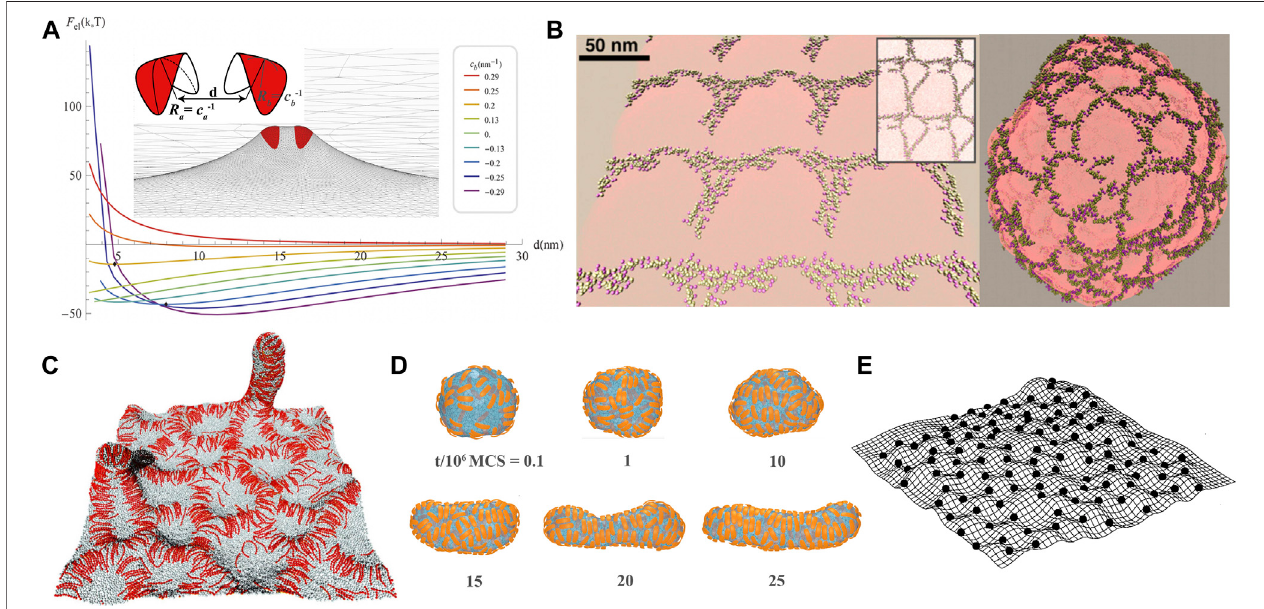
FIGURE5| Membrane-mediatedinteractionsbetweenanisotropicproteininclusions (A) andassemblyofanisotropicproteinsonmembranes (B – E) . (A) Curvature-induced elastic energy F el versus distance d of two BAR-like membrane scaffolds for different values of scaffold curvature c b (Schweitzer and Kozlov, 2015)(CC BY 4.0). The BAR-like scaffoldhasprinciplecurvatures c a and c b asillustratedintheinset.Whenprojectedtoinitialmembraneplane,thescaffoldhasanellipticalshapewithsemi-axesof6.5and1.5 nm. Themembranebendingrigidity κ (cid:1) 20 k B T . (B) LinearaggregationofN-BARson fl atandvesicularmembranesobservedincoarse-grainedMDsimulations(Simunovicetal., 2013).Copyright(2013)NationalAcademyofSciences. (C) Side-by-sidealignmentofBAR-likeparticlesonmembranebulgesandtubes(Noguchi,2016;NoguchiandFournier, 2017), with permission of The Royal Society of Chemistry. (D) MC sequence of con fi gurations of an initially spherical vesicle remodeled by arc-shaped scaffold. Reprinted from BonazziandWeikl(2019),copyright(2019),withpermissionfromElsevier.Freescaffoldsunboundtothemembranearenotshownhereforclarity. (E) Assemblyofsaddle- shaped protein inclusions (modeled by point-like particles that locally impose two opposite eigenvalues of the membrane ’ s curvature tensor) into regular pattern on the membrane. Reprinted from Dommersnes and Fournier (2002), copyright (2002), with permission from